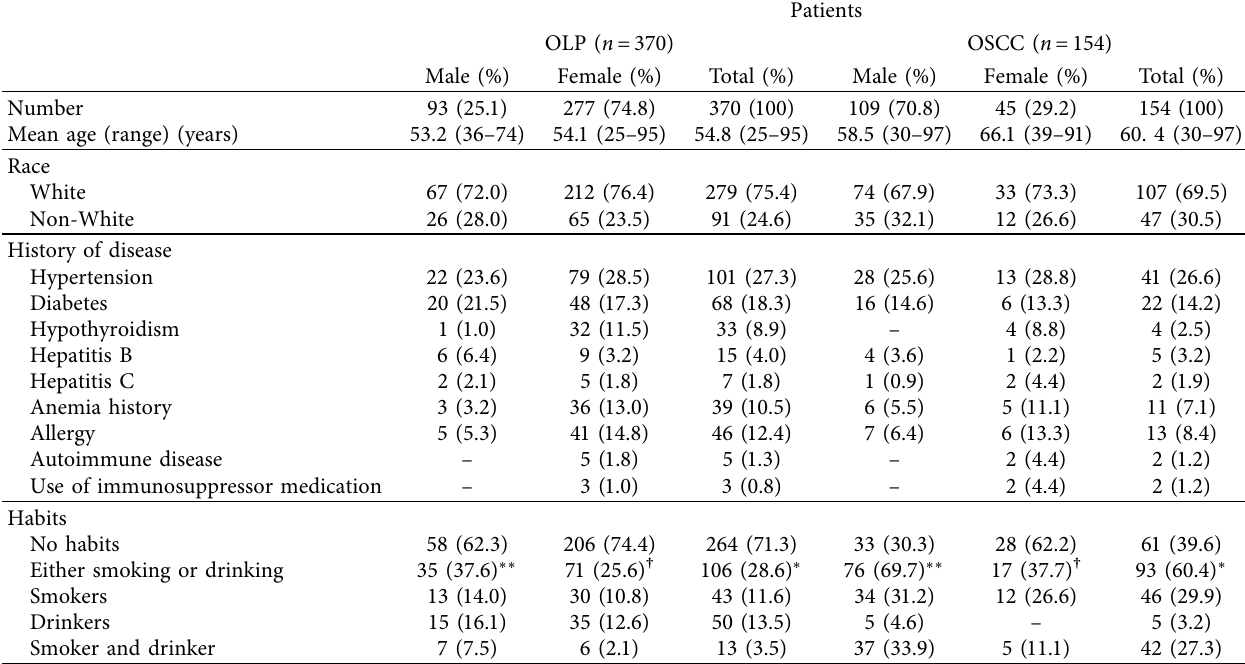
Table 1: Clinical profile and risk habits (smoking and alcohol consumption) in patients with oral lichen planus (OLP) and oral squamous cell carcinoma